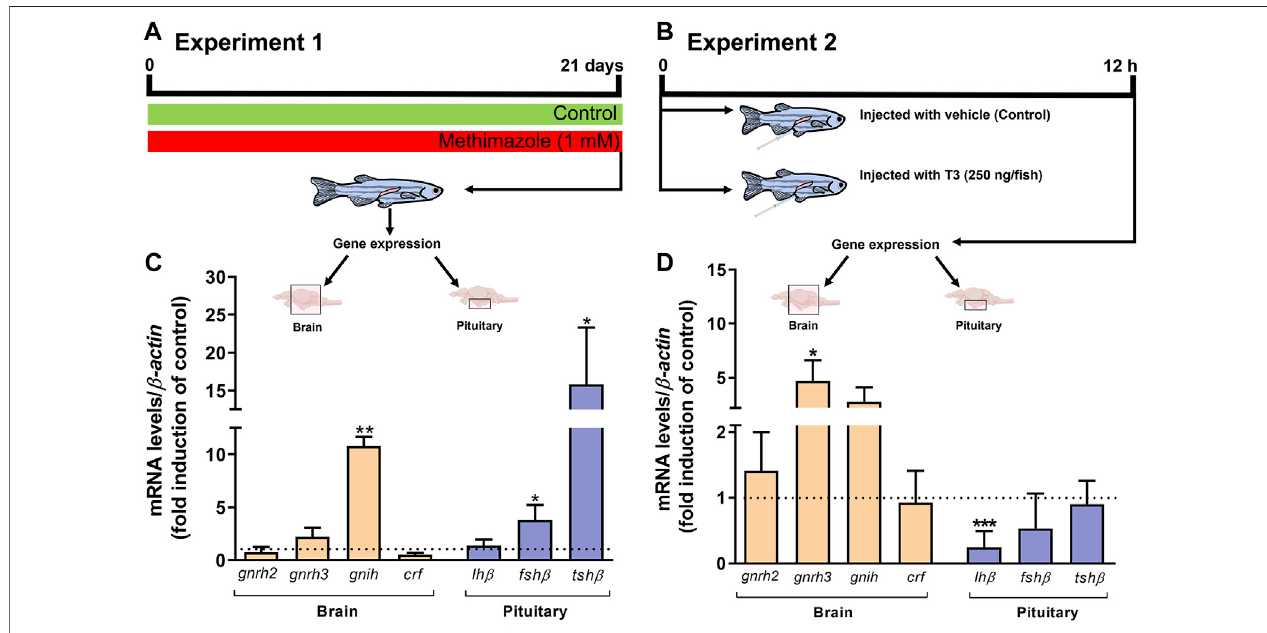
FIGURE 5 | (A) Experiment 1: zebra fi sh adult males were exposed to methimazole-induced hypothyroidism for 3 weeks. (B) Experiment 2: zebra fi sh adult males were injected with 0 or 250 ng of T3/ fi sh and tissue were collected 12 h post-injection. Relative mRNA levels of selected genes, including gnrh2 and gnrh3 (gonadotropin-releasinghormones), gnih (gonadotropin-inhibitoryhormone),and crf (corticotropin-releasinghormone), expressedinthebrain( n =8),and lh β (luteinizing hormone), fsh β (follicle-stimulating hormone), and tsh β (thyroid-stimulating hormone) expressed in the pituitary ( n = 4 pools of 4 pituitaries for each pool) from the methimazole group (C) and 12 h post-injection with 0 and 250 ng of T3/ fi sh (D) . Ct values were normalized with β -actin and expressed as relative values of control (no- treated fi sh)levelsofexpression.Barsrepresentmean±SEMfold-changerelativetothecontrol,whichissetat1.Studentunpaired t -test,* p < 0.05, **p < 0.01 and*** p <